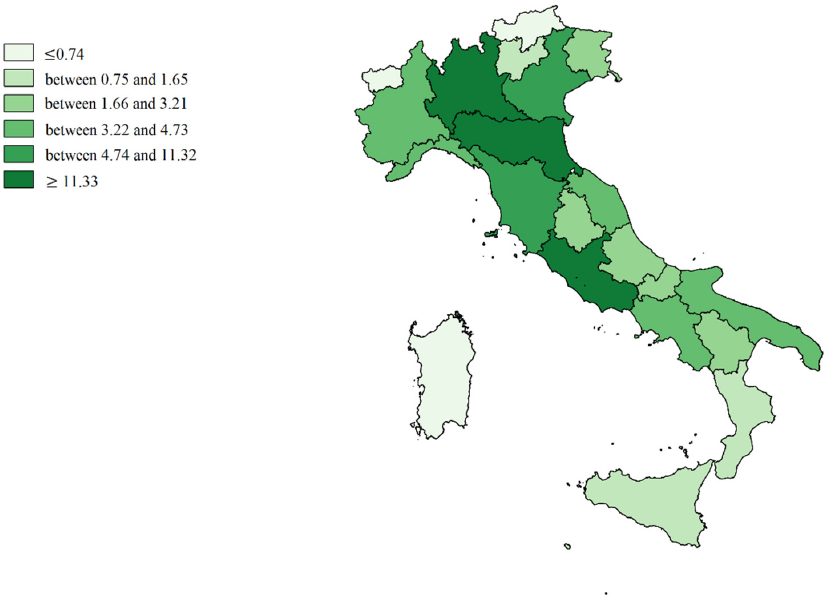
Figure 5. Cartographic representation of regional Attraction Absorption Indexes (AAI), mean from 2013 to 2017.